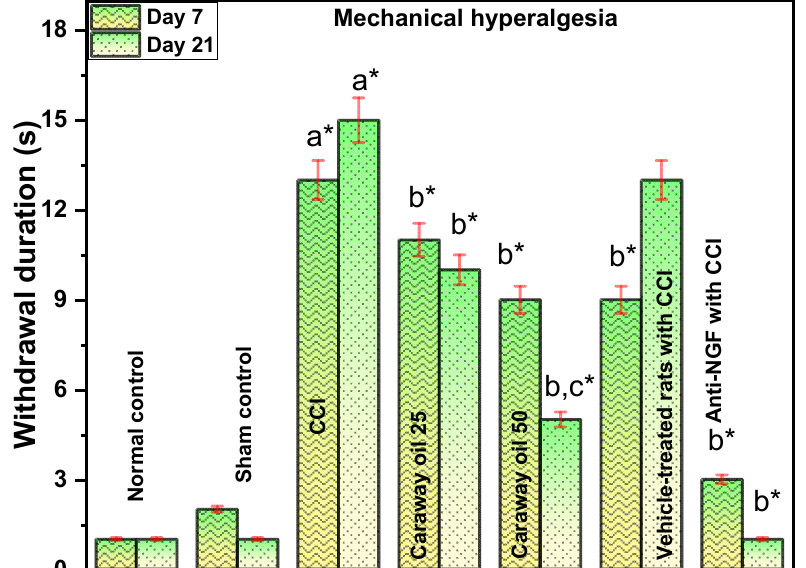
Figure 3. Effect of caraway oil on CCI-induced mechanical hyperalgesia assessed by pinprick test. Values are given as mean ± SEM, n = 6. a p ≤ 0.05 versus sham control corresponding to same day. b p ≤ 0.05 versus CCI corresponding to same day. c p ≤ 0.05 versus Caraway oil and anti-NGF in CCI corresponding to same day. * represents p -value ≤ 0.05.